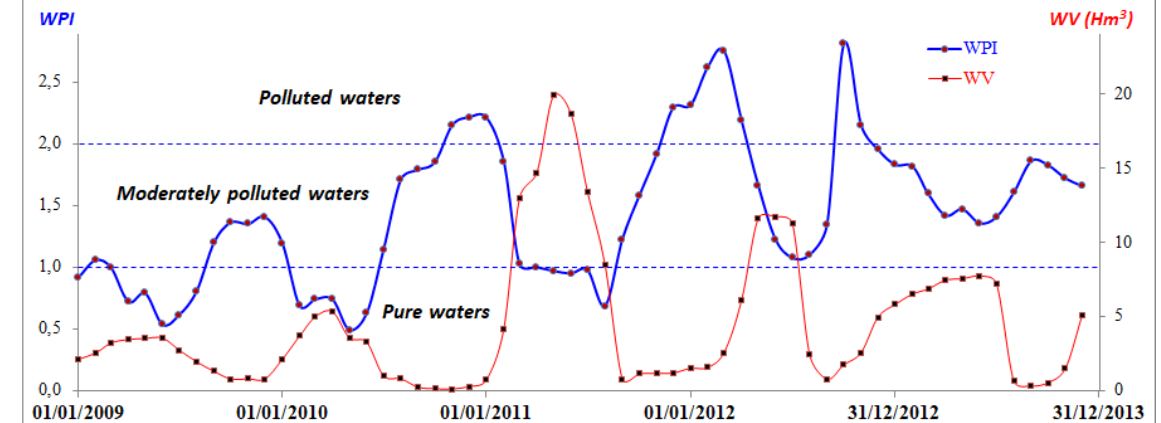
Fig. 10. Variation of the WPI in the dam of Oued Fodda from 2009 to